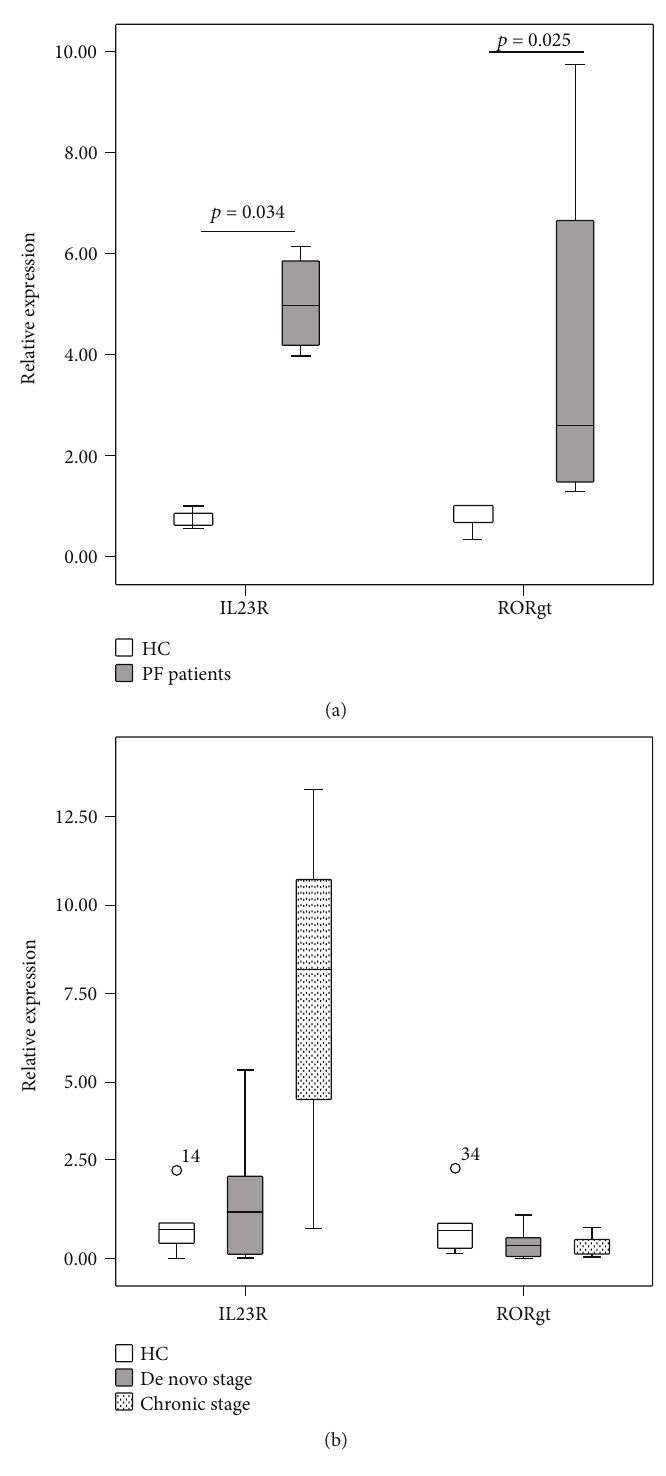
Figure 3: mRNA expression of IL23R and ROR γ t in peripheral blood (a) and skin biopsies (b). PBMCs were extracted from 5 de novo patients and 4 HC. Biopsies from de novo patients ( N = 10 ), patients in the chronic stage ( N = 3 ), and from HC ( N = 5 ) were analyzed using Q-PCR. The relative expression was estimated using 2 − ΔΔ Ct method and normalized to the average of the GAPDH housekeeping gene. P value was calculated using Mann – Whitney U